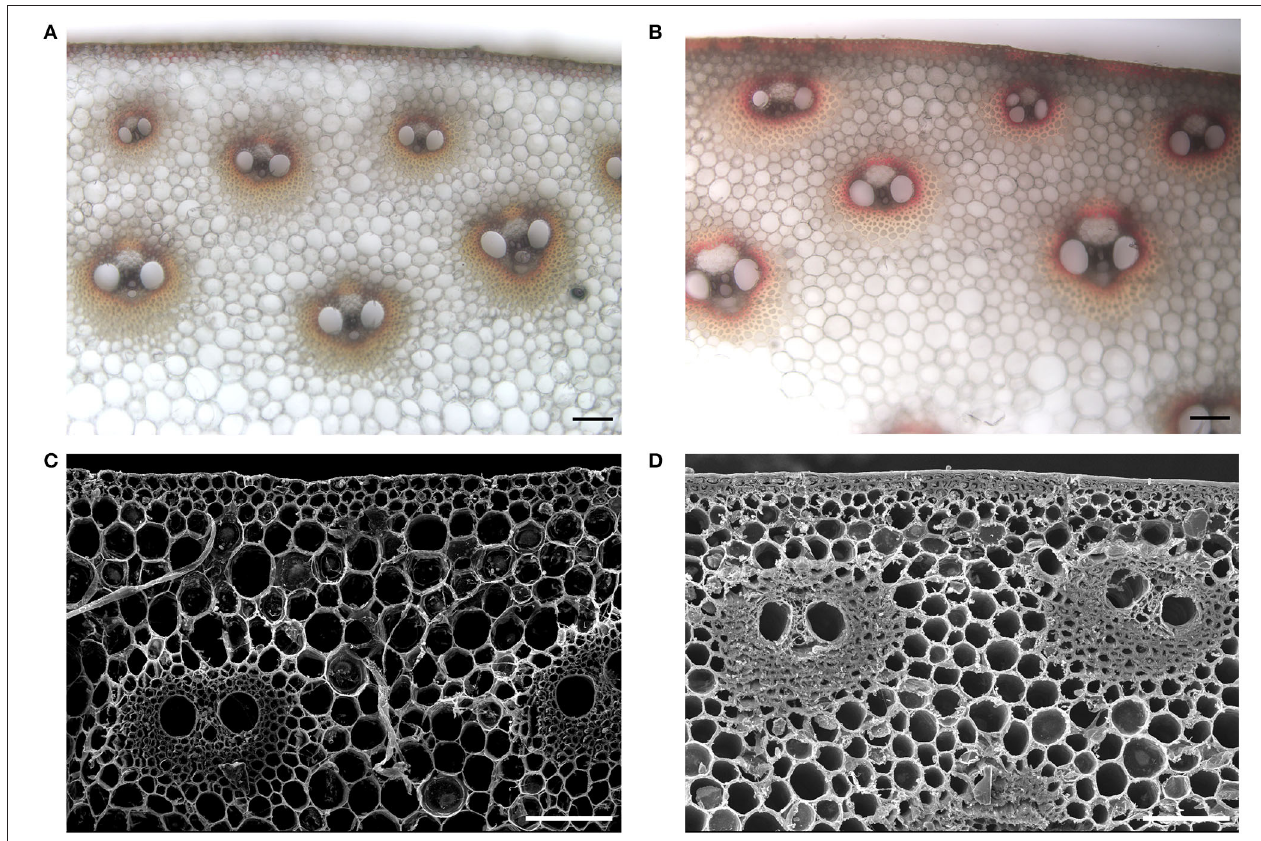
FIGURE 2 | Morphological characteristic of cross-sections of the third internodes below the primary ear in 3705I and LH277. (A,B) Are phloroglucinol staining of lignin of 3705I stems and LH277 stems, respectively. A scale bar of (A,B) , 100 µ m. (C,D) Are SEM images of cross-sections of 3705I stems and LH277 stems, respectively. A scale bar of (C,D) , 100 µ